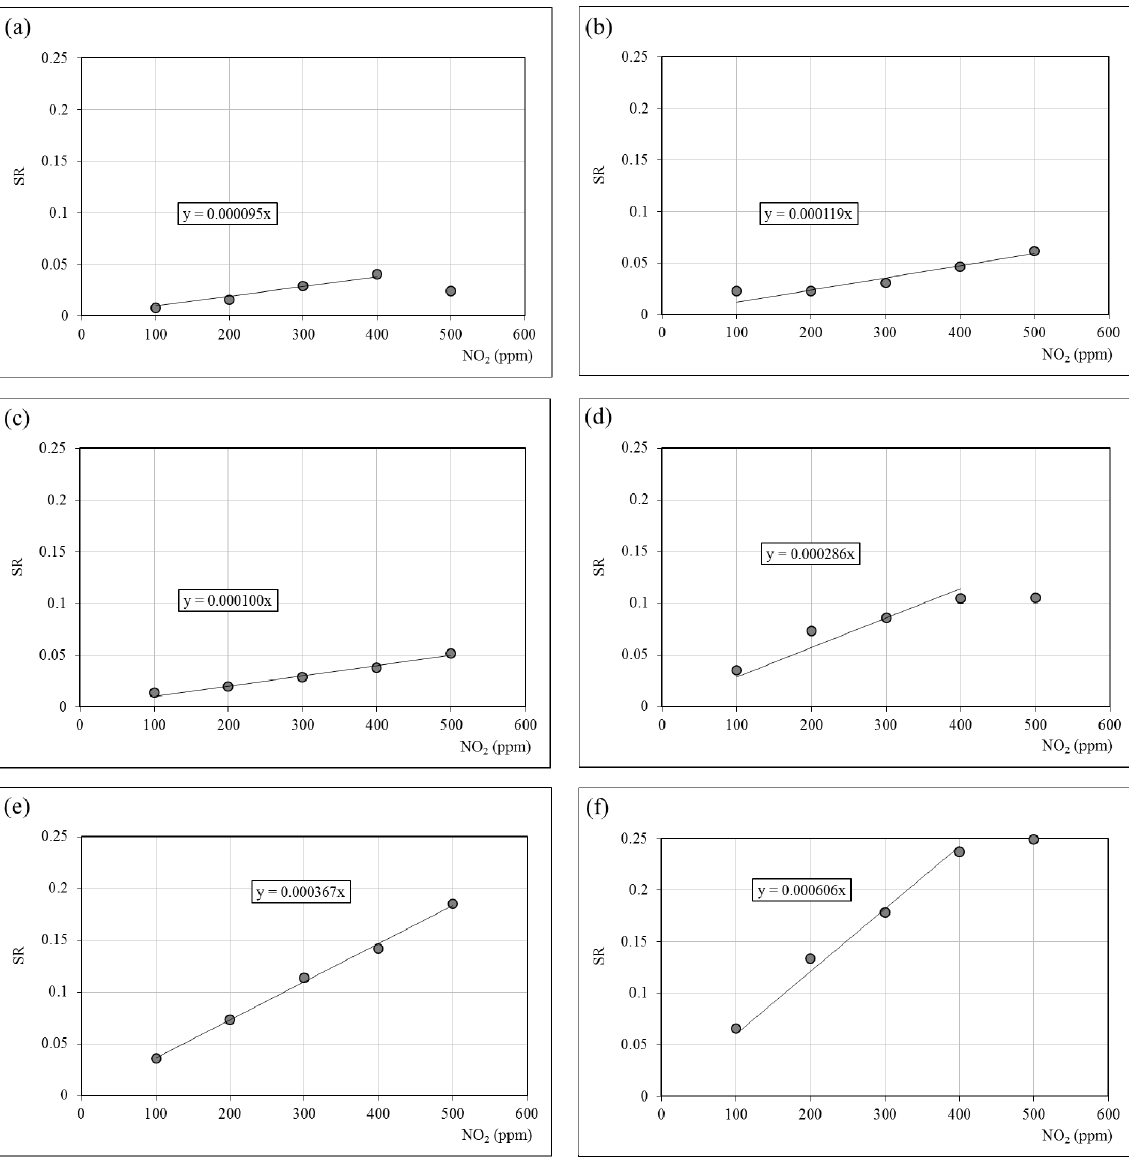
Figure 8. Sensor response (SR) evolution at 200 °C on the samples ( a ) H; ( b ) 3% BA; ( c ) 4% BA; ( d ) 5% BA; ( e ) 10% BA; ( f ) 14% BA in 0–500 ppm NO at 1000